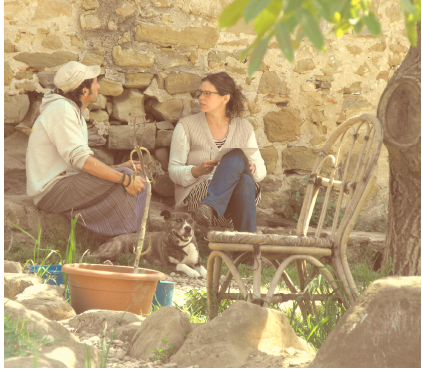
Table 1. Organization of the